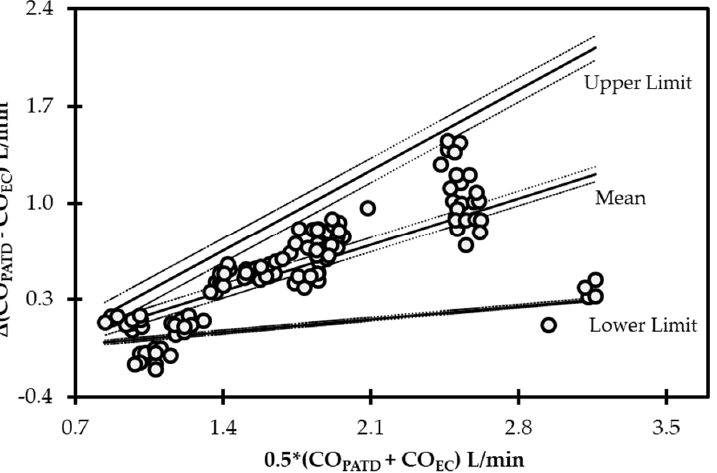
Figure 5. Bland − Altman analysis for non-uniform differences using cardiac output (CO) values measured using electrical cardiometry (CO EC ) and pulmonary artery thermodilution (CO PATD ) techniques in anesthetized Beagle dogs ( n = 6) across fi ve timepoints during four hemodynamic events (baseline, hemorrhage, autologous blood transfusion, and colloid infusion), thus yielding 120 paired observations (circles). Each circle represents an individual di ff erence value corresponding to an average value and mean shows a strong positive bias (slope = 0.48; intercept = − 0.31) indicating underprediction. As displayed, the solid lines indicate the mean and upper and lower limits of agreement, and the dashed lines indicate the 95% con fi dence intervals around these values.